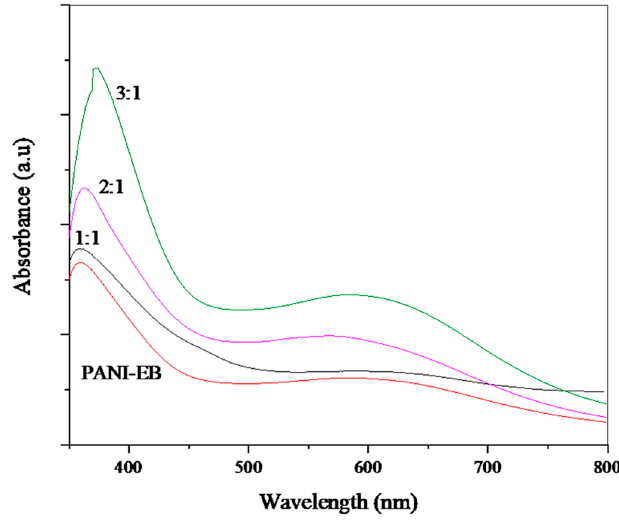
Figure 2. UV-vis spectra of PANI, starch, and PANI/starch biocomposites in DMF.